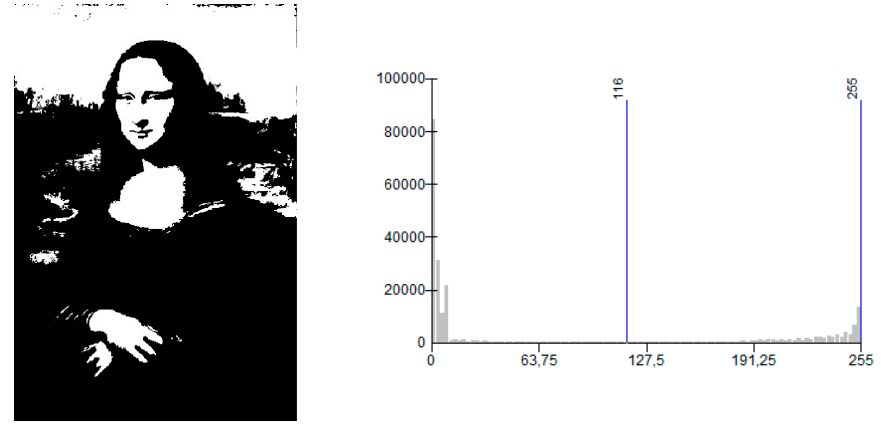
Figure 6. Classified frequency image and its pixel values frequency histogram.